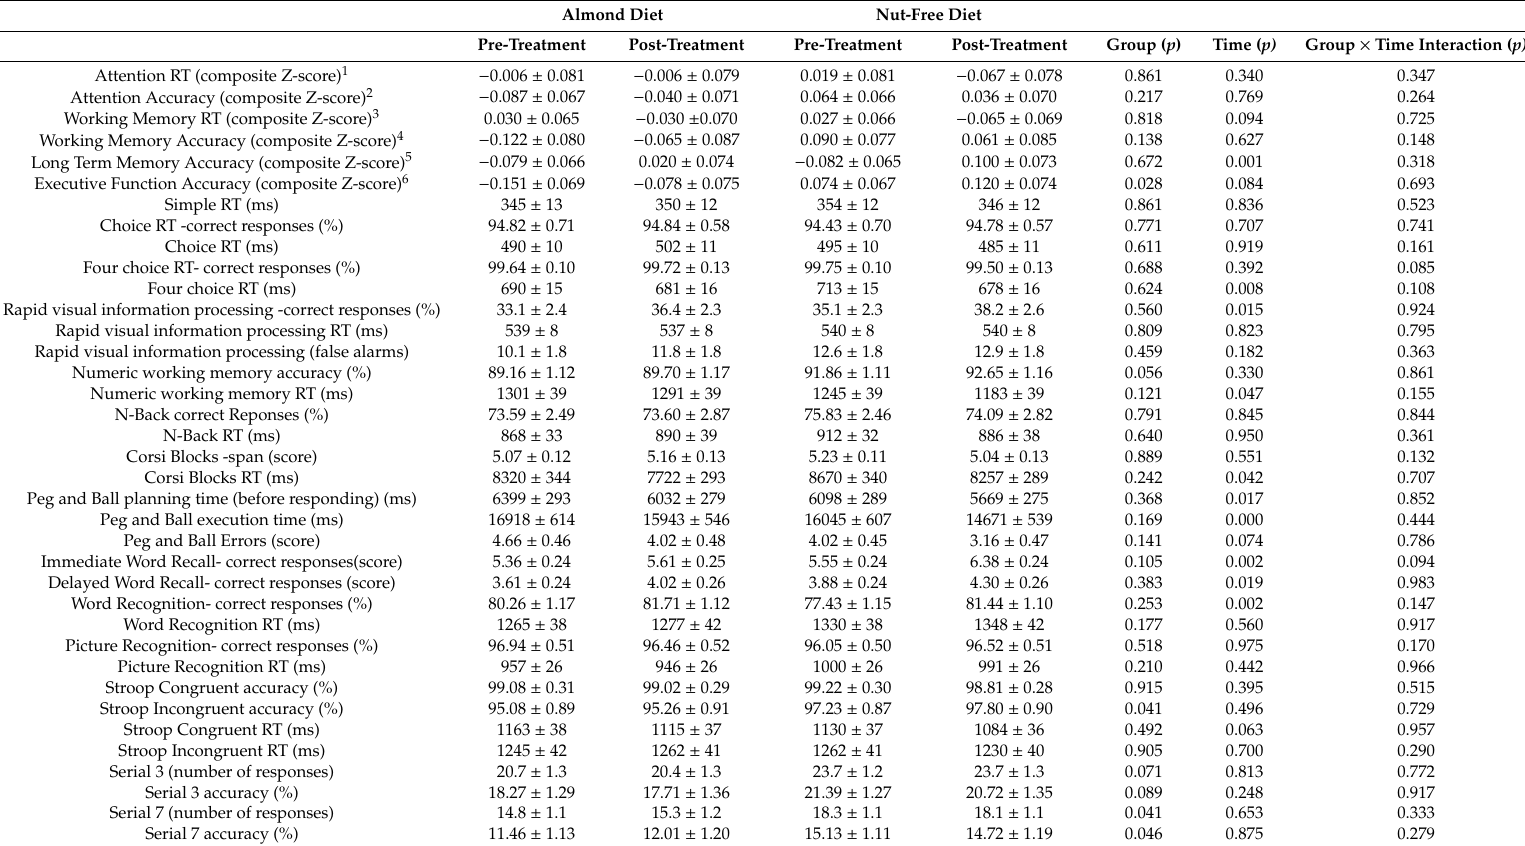
Table 3. E ff ect of treatment on